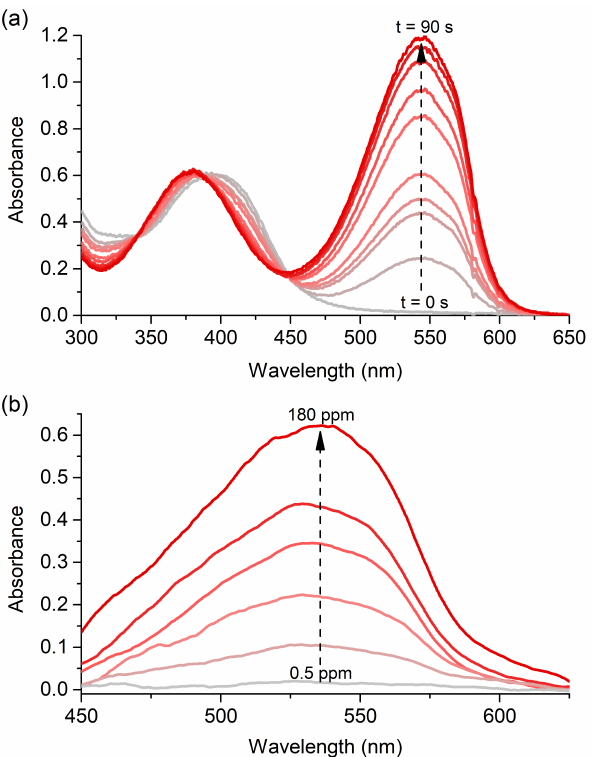
Figure 2. ( a ) Time-dependent response of the colorimetric probe. Exposure of a 32.5 µ M (NBD) 2 S methanol solution to 750 ppm of H 2 S (bubbled in a N 2 stream) in the 0–90 s range. ( b ) Spectral response of the embedded paper strip under an exposure of 15 min to H 2 S atmospheres of different concentrations in the 0–180 ppm